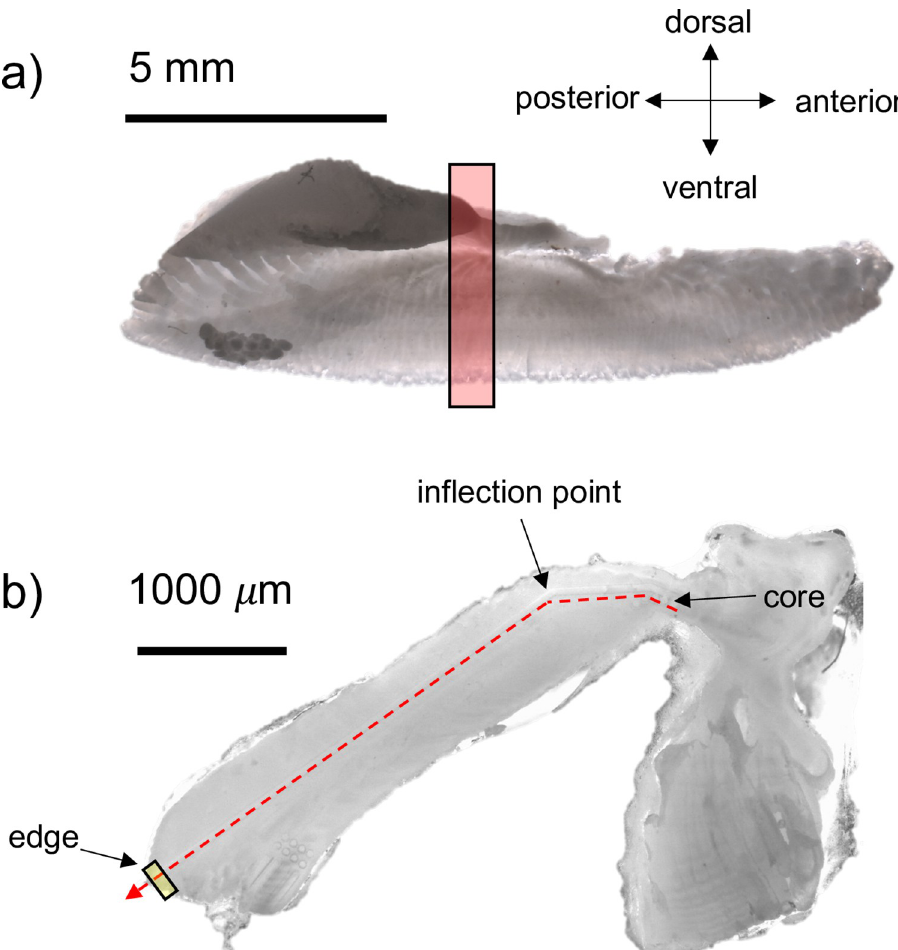
Fig 2. Schematic of Pacific bluefin tuna otolith preparation for elemental analysis. Otoliths of PBT were sectioned in the transverse plane (a, red shaded box) and the ~1 mm section was polished to expose the core; a laser scan (b, red dashed line) starting from the early life core region was scanned across the otolith growth bands encompassing the complete life history, with the laser path turning at the inflection point; the final 100 μ m of data (small yellow box) was averaged to represent the recent otolith material deposited in the region of